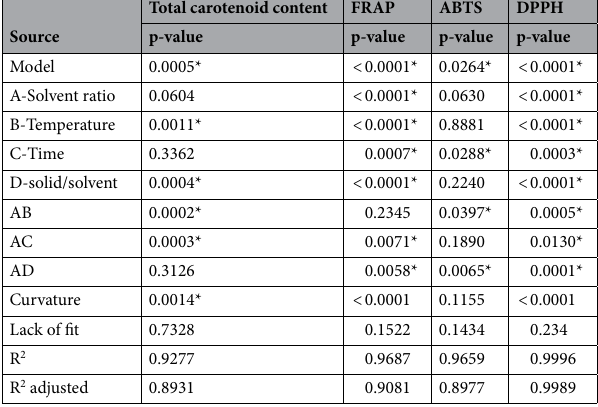
Table 3. ANOVA and regression analysis of Fractional factorial design responses of Study